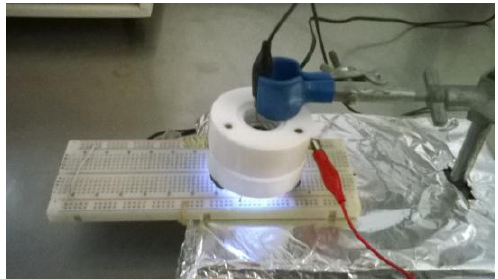
Figure 2. Photography of the experimental setup with a light white source used in this